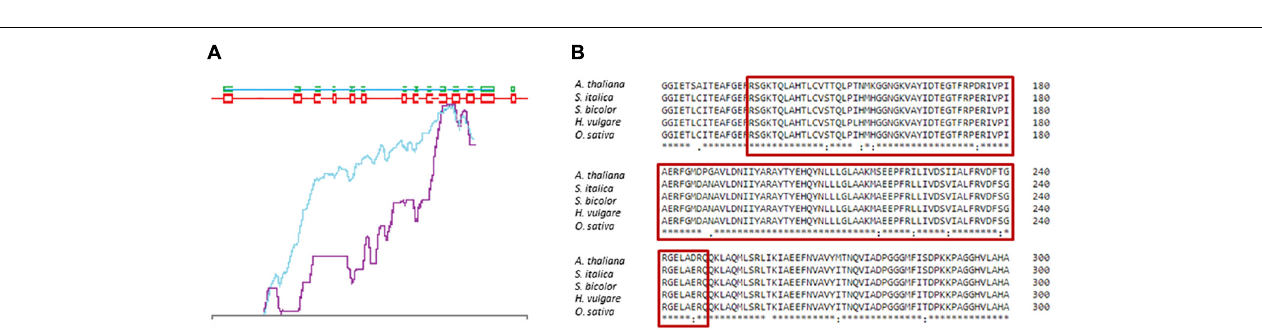
FIGURE 1 | (A) The structure of the HvDMC1 gene. Blue boxes symbolize exons and orange lines introns. The identified mutations are indicated by asterisks (red – missense mutations, black – mutations in non-coding regions). (B) The structure of the HvDMC1 protein with localization of the Rad51 domain. Orange boxes symbolize the Walker A and Walker B functional motifs that are responsible for ATP binding, red boxes symbolize ssDNA-binding loops 1 and 2. The positions of amino-acid residues mutated in the dmc1.c and dmc1.b alleles are indicated by red asterisks.